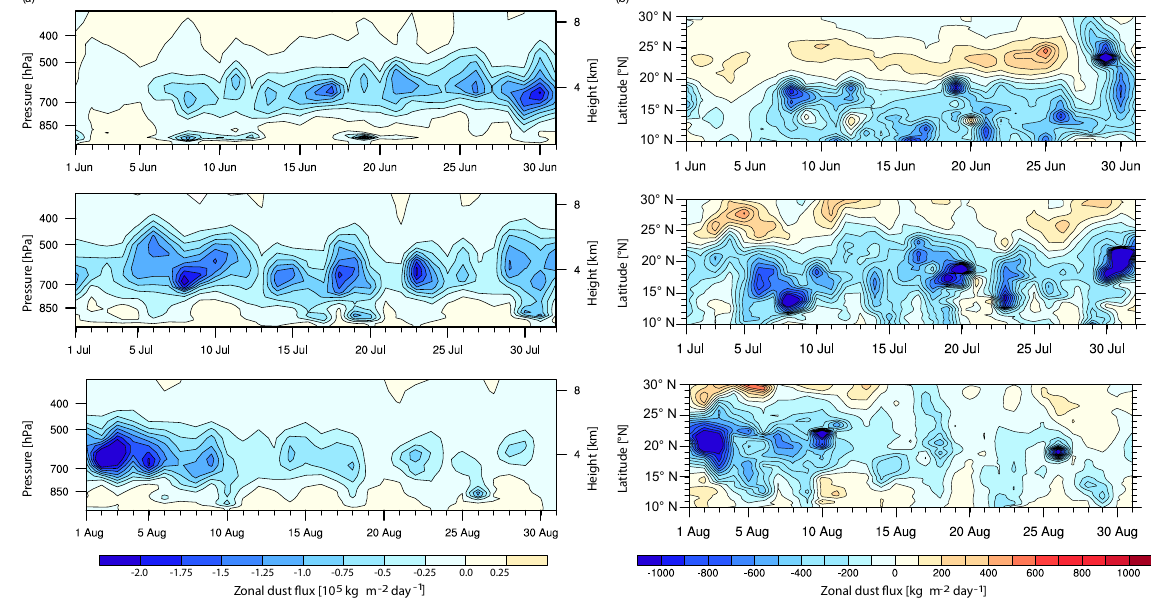
Figure 12. (a) Zonal dust flux (kgm − 2 day − 1 ) at 20 ◦ W. Dust export towards the North Atlantic is represented by negative values; positive values indicate transport back to the northern African continent. Dust fluxes are totals over the 10–25 ◦ N latitudinal band. (b) Zonal dust flux (kgm − 2 day − 1 ) at 20 ◦ W. Dust export towards the North Atlantic is represented by negative values; positive values indicate transport back to the northern African continent. Dust fluxes are totals over the vertical column (0–22km).